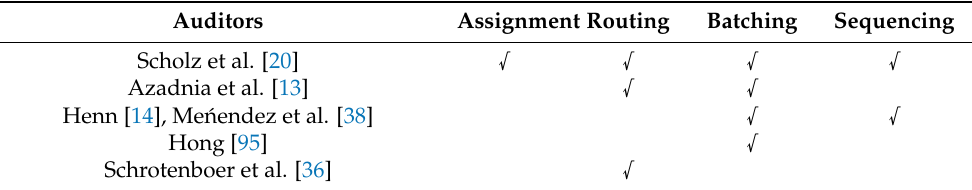
Table 5. Overview of the reviewed articles in minimizing